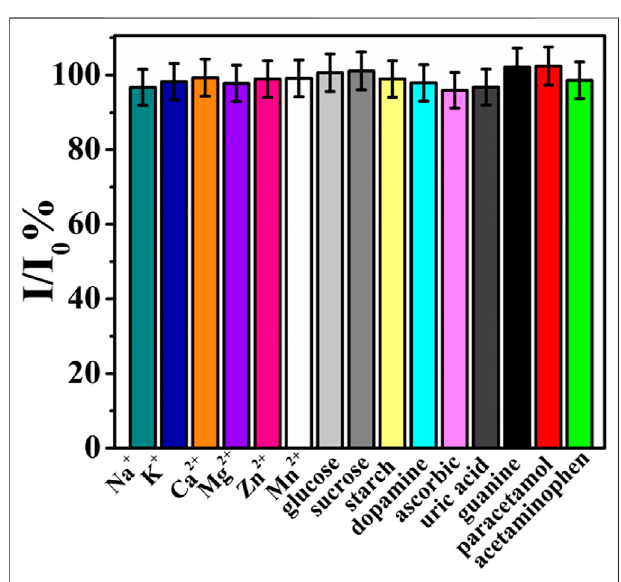
FIGURE6| Currentratio(I/I 0 )ofrGO – TiO 2 – Au/GCEwith100 μ MACVin the presence of possible interfering